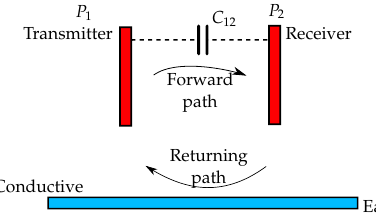
Figure 8. Two-plate structure.